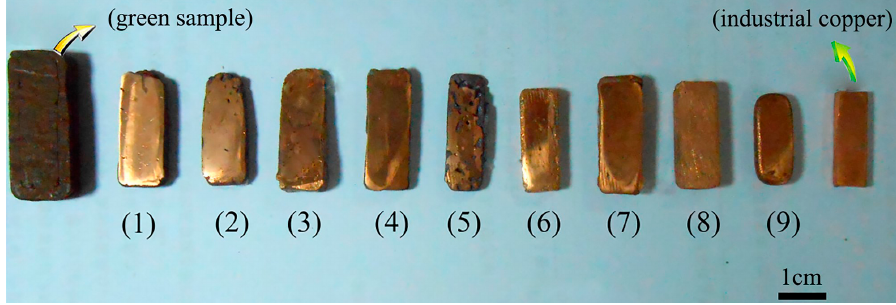
Figure 10. Sintered samples with different sintering parameters corresponding to Table 7.